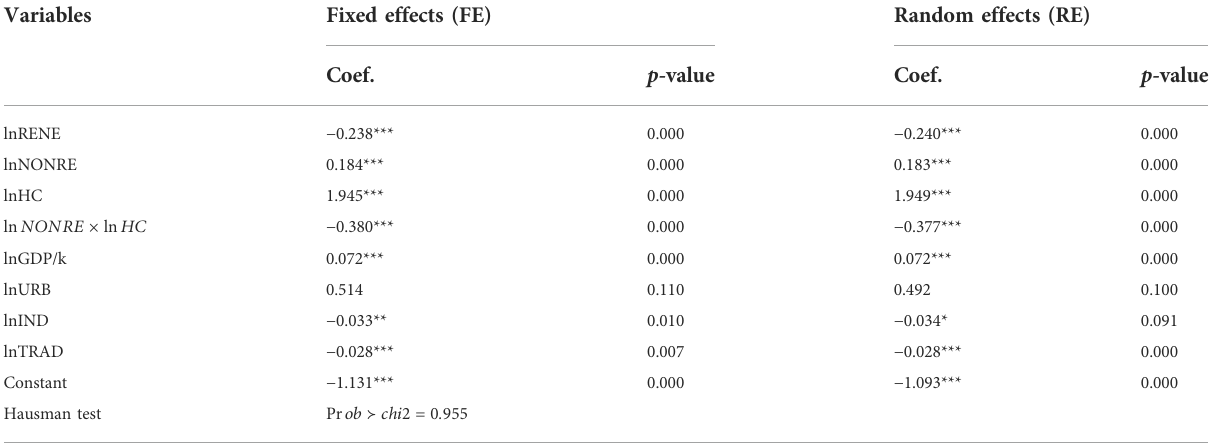
TABLE 13 Results of the moderating effect of human capital on the nonrenewable energy-CO2 emissions nexus using the FE and RE estimators.